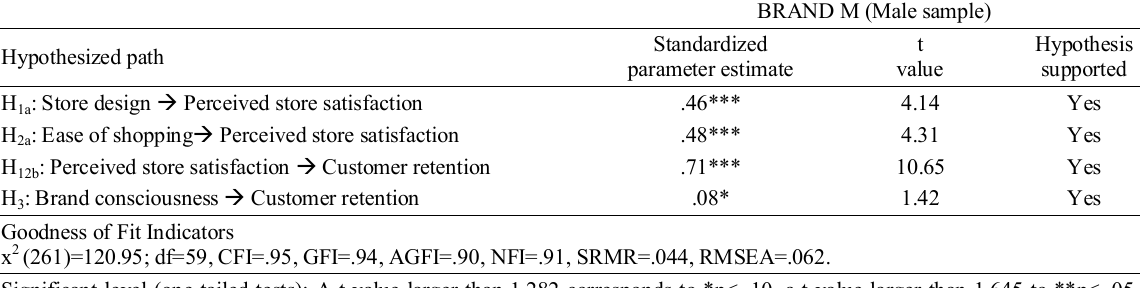
Table 4. Proposed Research Model Parameter Estimates with Significance Levels (Brand